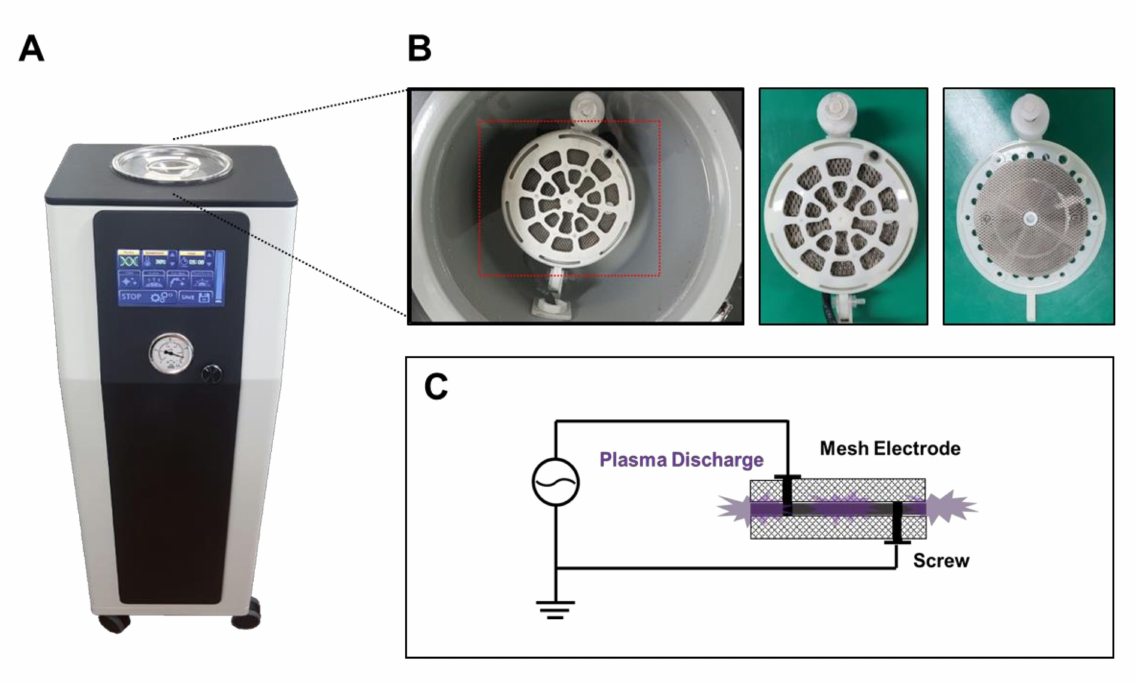
Figure 1. ( A , B ) Main body of the device showing the cleaning solution container with the plasma module and ( C ) the schematic principle for underwater plasma